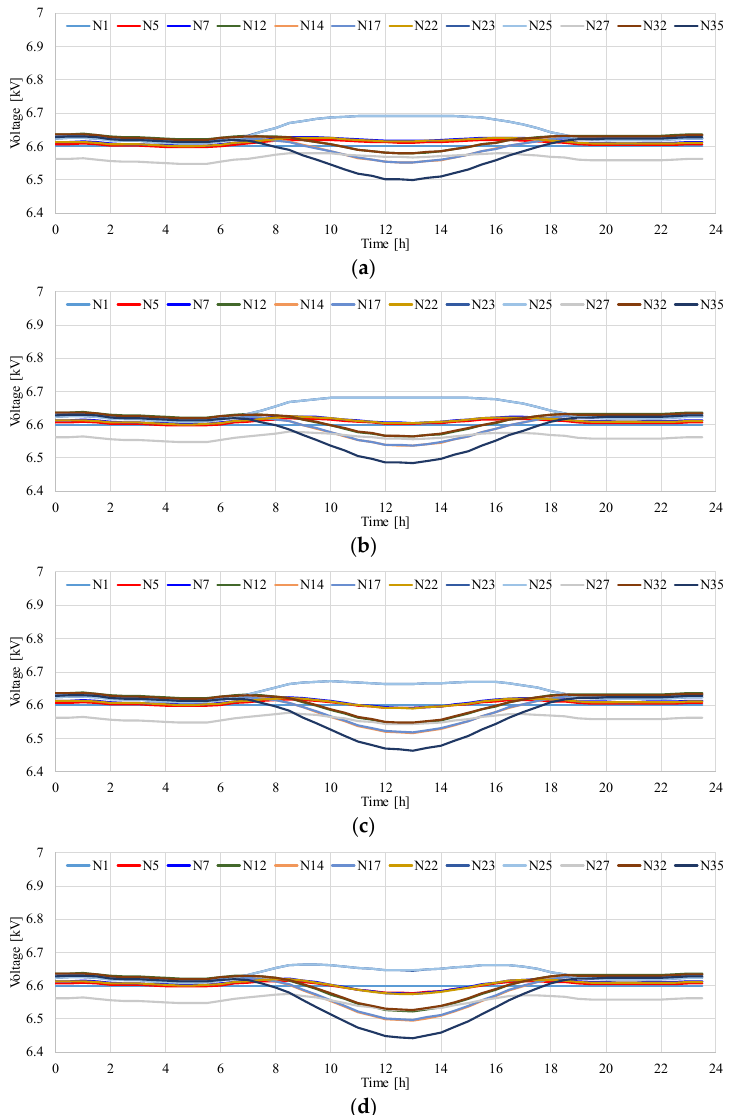
Figure 12. Time variation in voltage at MV distribution feeder with PCS for which the power factor is set to 0.95: ( a ) Case A2; ( b ) Case B2; ( c ) Case C2; ( d ) Case D2.